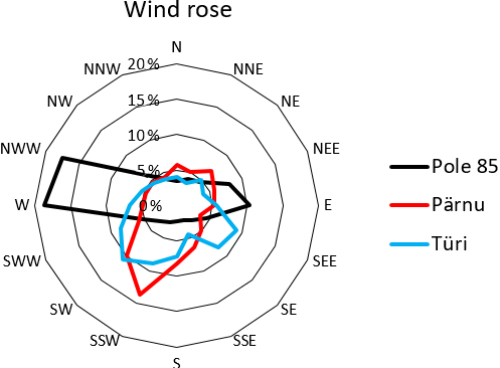
Figure 3. Wind rose in pole 85 compared to hourly weather obser- vation data from Pärnu and Türi weather stations.